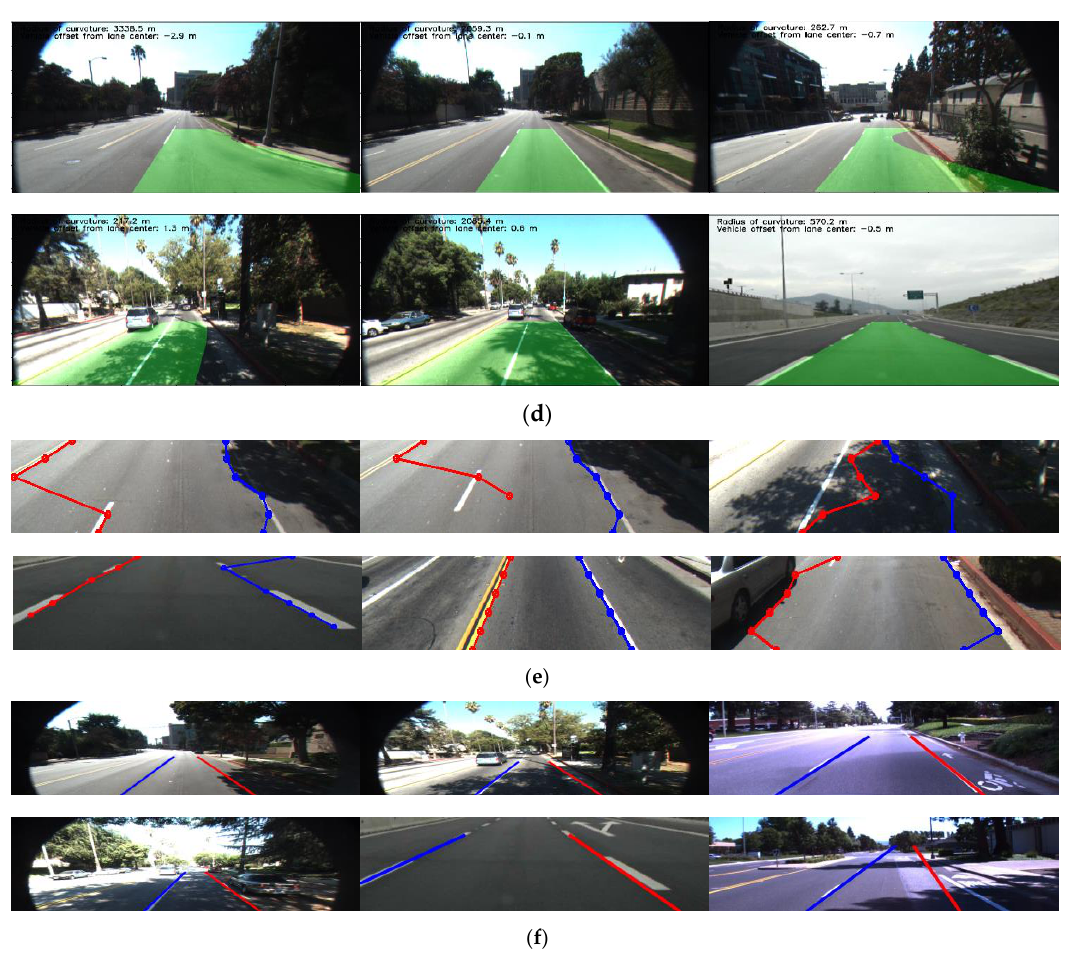
Figure 22. Comparison of lane detection: ( a ) our method; ( b ) Hoang et al.’s method [6]; ( c ) Aly method [5]; ( d ) Kylesf method [7]; ( e ) Truong et al.’s method [4]; ( f ) Nan et al.’s method [1].